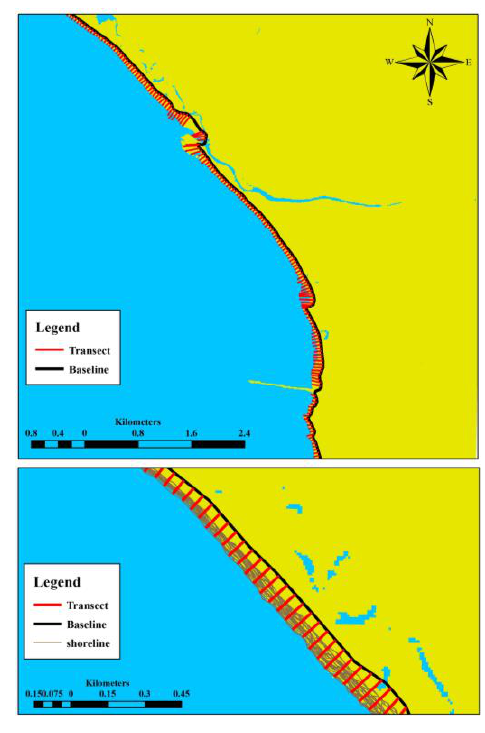
Figure 8. Drawn transects at a distance of 50 m perpendicular to the baseline .